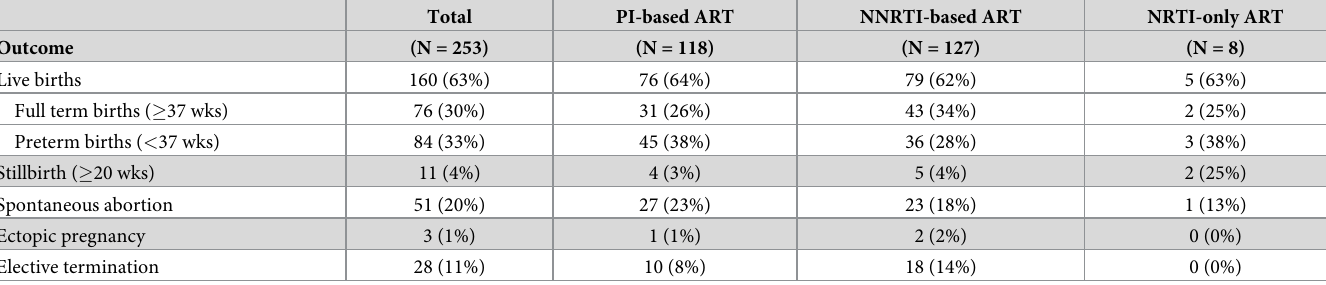
Table 2. Pregnancy outcomes among HIV-infected women on ART prior to